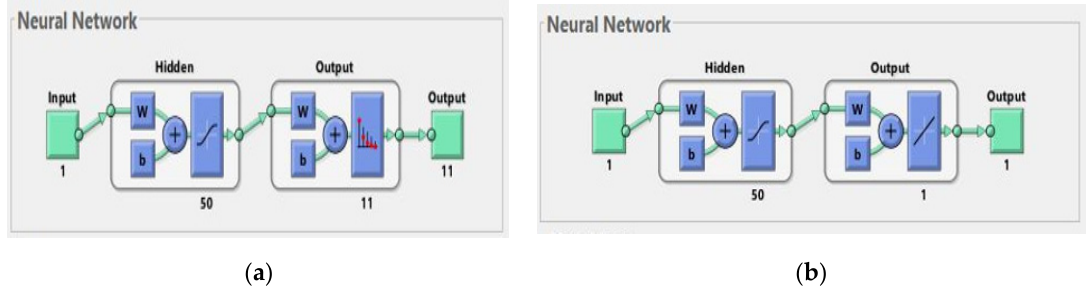
Figure 9. ( a ) Pattern recognition neural network training; ( b ) model fitting neural network training.